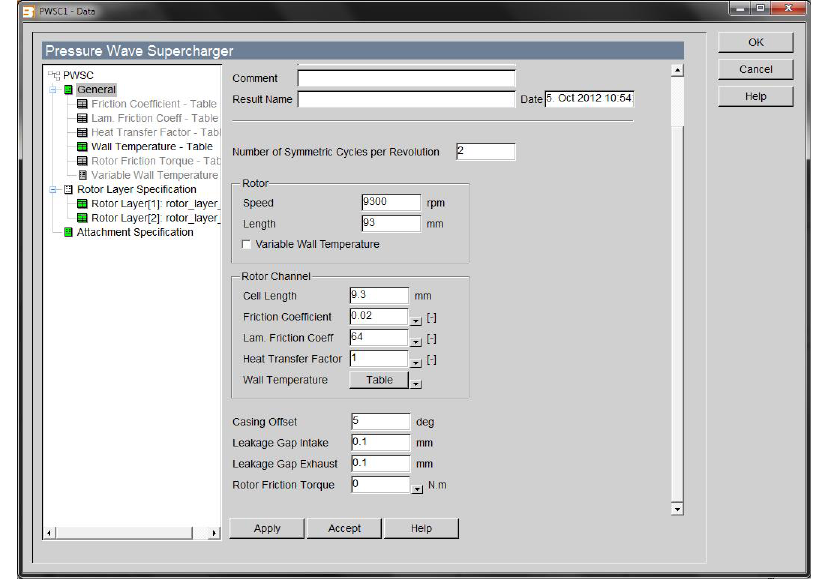
Figure 8. Pressure wave supercharger